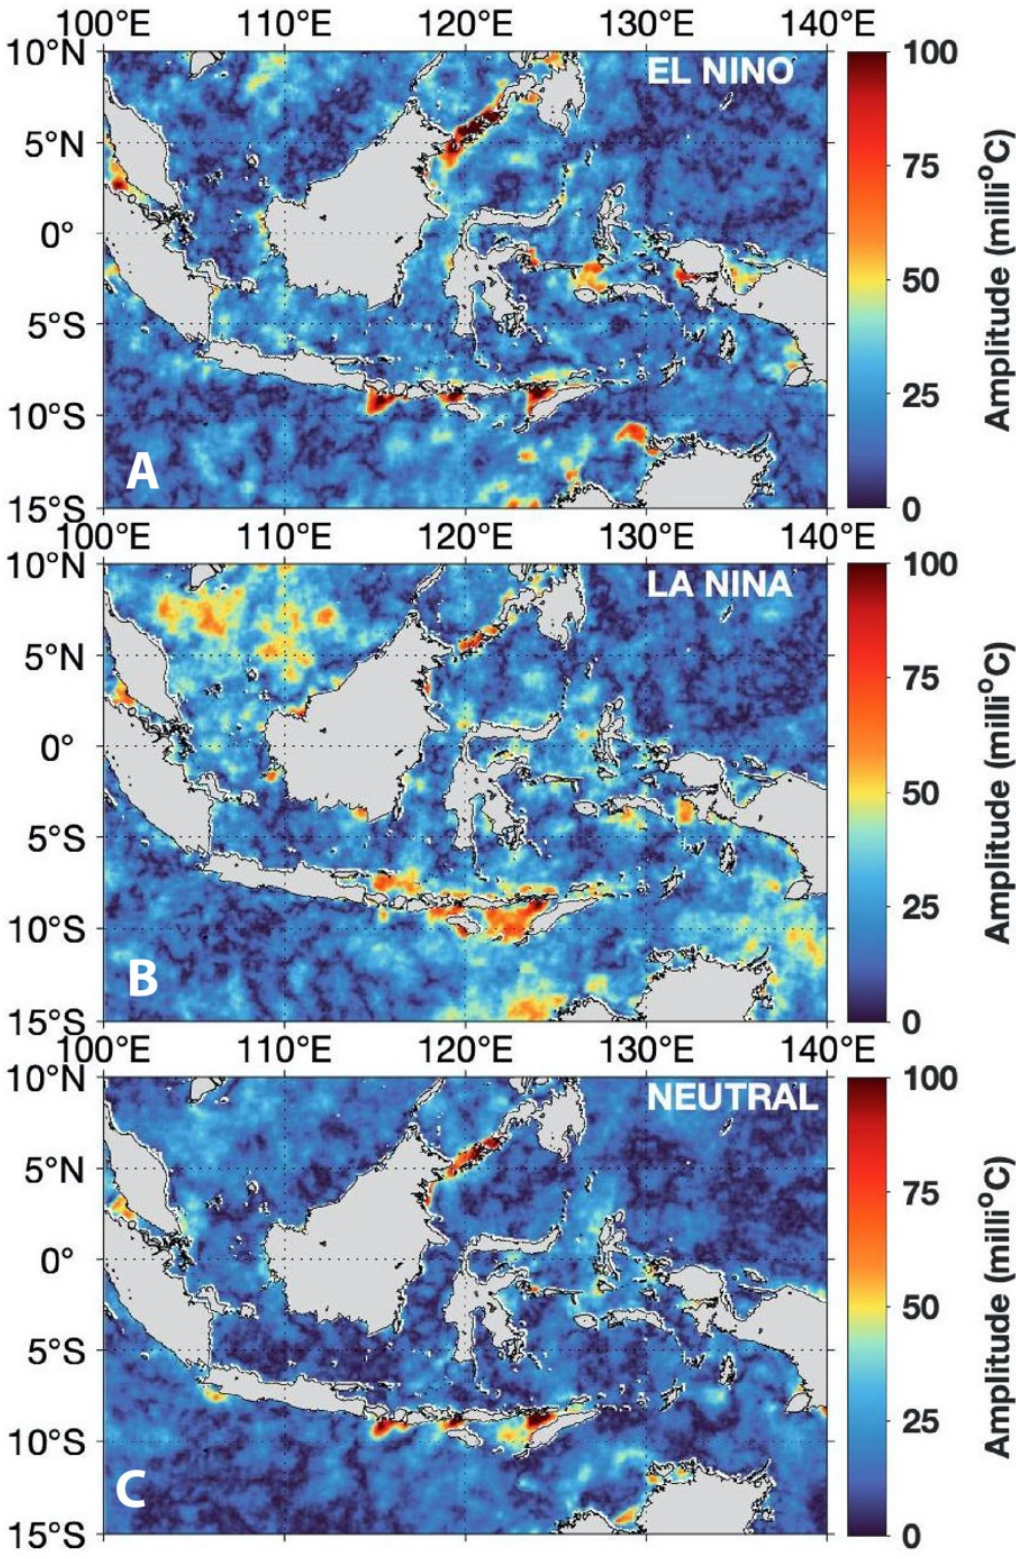
Figure 7. The amplitude of the fortnightly signal (MSf): ( A ) During El Niño year; ( B ) During the La Niña year, and ( C ) During the normal year. Tidal mixing signatures are stronger/more robust during the El Niño year, where ITF is less than in the La Niña.